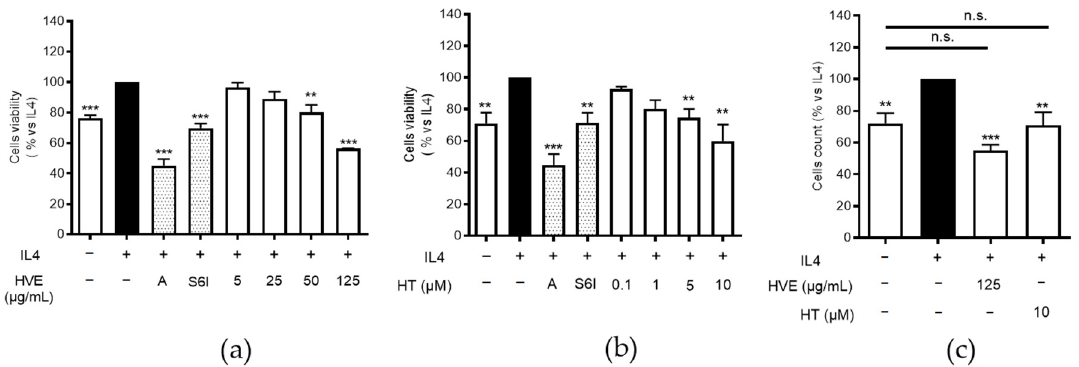
Figure 7. The inhibitory effect of HVE ( a ) and HT ( b ) treatment (72 h) on cell proliferation induced by IL-4 (100 ng/mL) in HaCaT cells (MTT assay). The effect of HVE (125 µ g/mL) and HT (10 µ M corresponding to 4.93 µ g/mL) measured by the trypan blue test is also reported ( c ). The data are expressed in percentages, relative to the stimulated control, which is arbitrarily assigned a value of 100%. ** p < 0.01, *** p < 0.001 versus stimulus. HVE, Hamamelis virginiana bark extract; HT, hamamelitannin; reference inhibitors: A, apigenin (20 µ M); S6I, STAT-6 inhibitor (50 nM). n.s., no